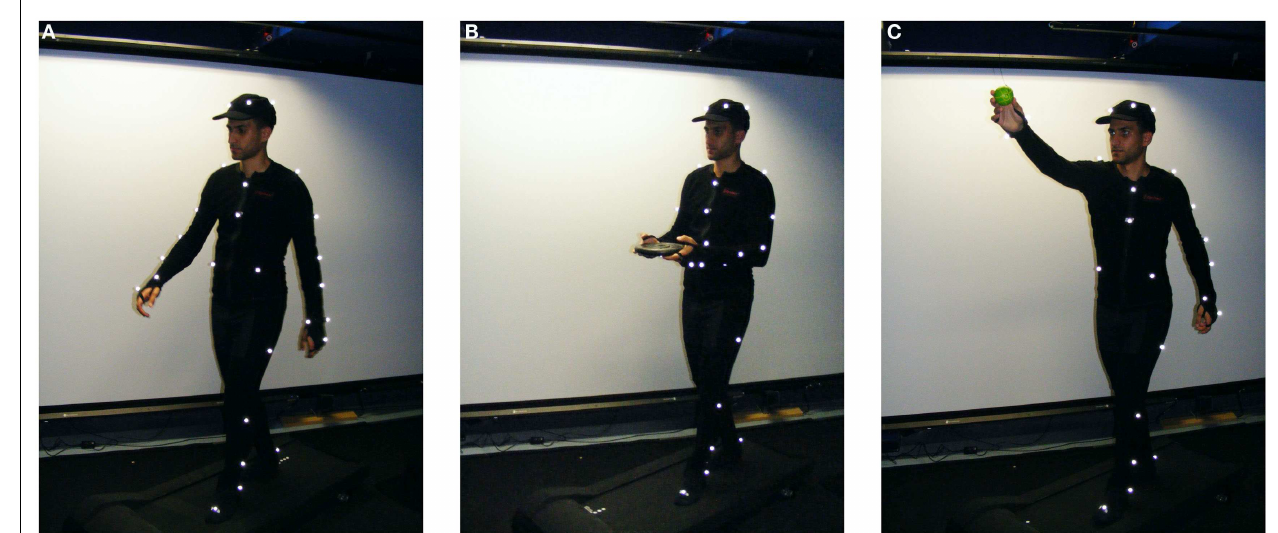
FIGURE 1 | One of the subjects (A) walking on the treadmill with no constraints, (B) walking on the treadmill holding a 5kg load, and (C) reaching for a ball with his right hand while walking on the